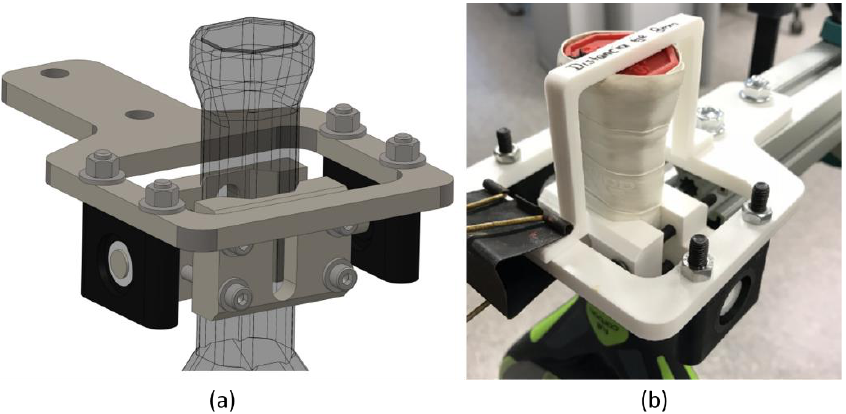
Figure 6. Setup for the horizontal rotation. ( a ) Computer-aided design (CAD) model. ( b ) The limiter positions the racket with a defined distance between the rotation axis and grip end. A trifilar pendulum is used to determine the MOI around the vertical axis. The rotation body is hung up with three strings to enable oscillation (Figure 7).